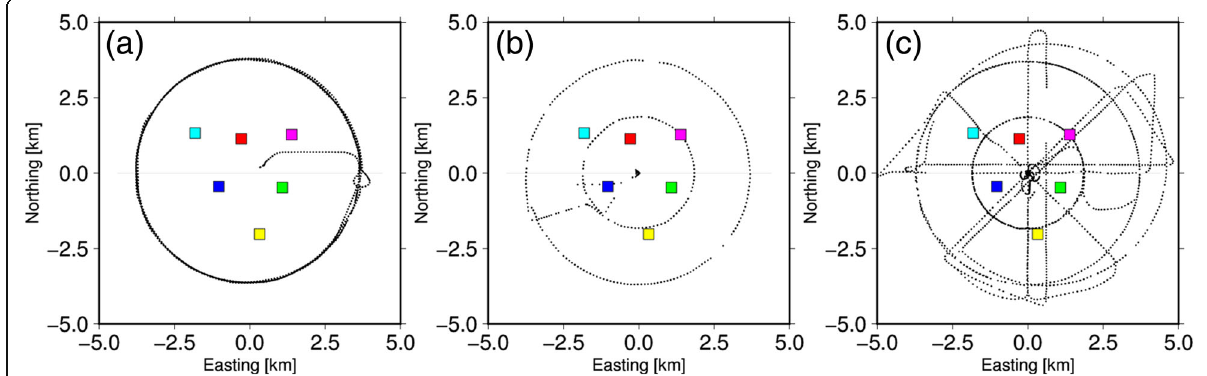
Fig. 3 Data distribution of three ship-based observations. The black dots represent the observation position in a moving or point survey. The colored squares are the six PXPs, which correspond to the residuals in the determination of the array geometry (Additional file 1: Figure